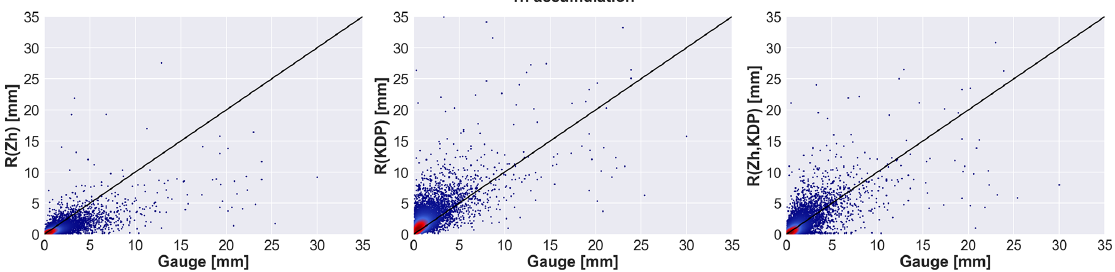
Figure 5. Scatter plots of radar-based rainfall estimates against rain gauge observations for 1h accumulation intervals in Estonia 2011–2018. The corresponding verification measures are presented in Table 3. The number of radar–gauge data pairs with eight gauges and accumulations > 0 . 1mm is 7019. Z H is not corrected for attenuation.